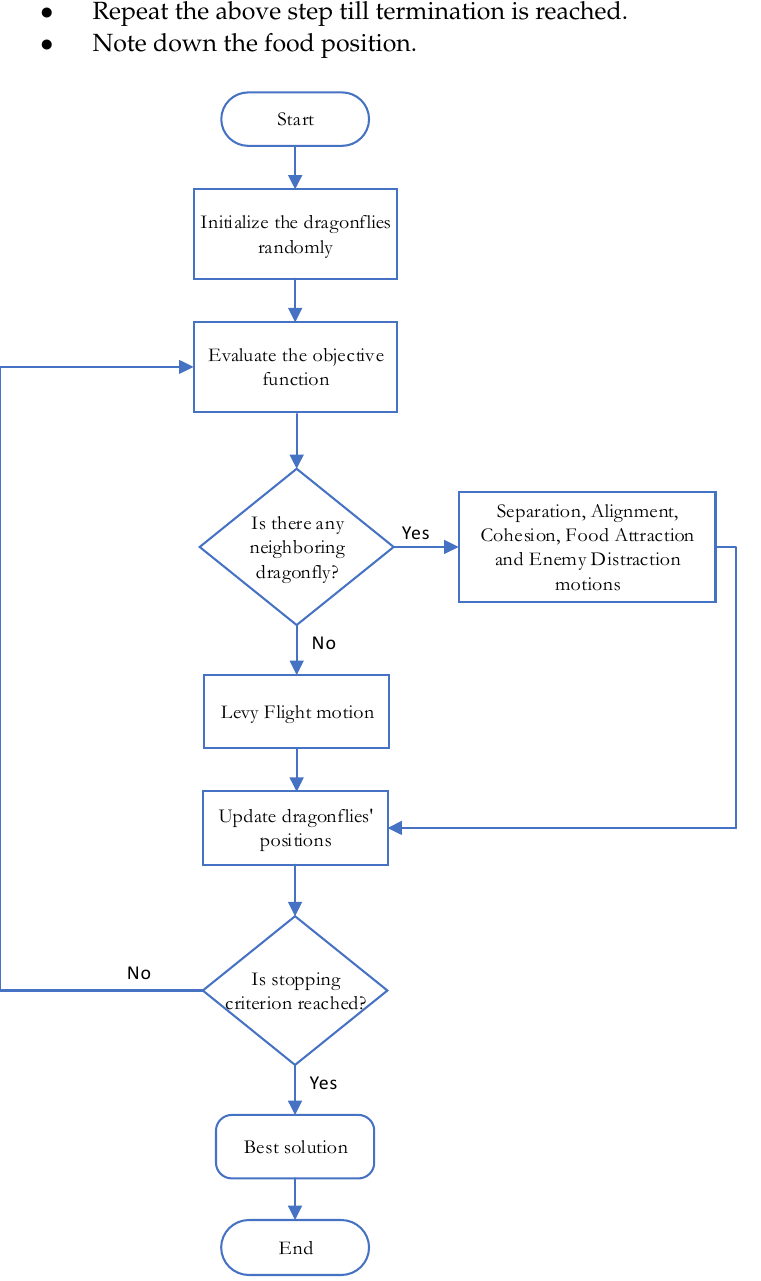
Figure 4. Flowchart for Dragonfly Algorithm (DA).